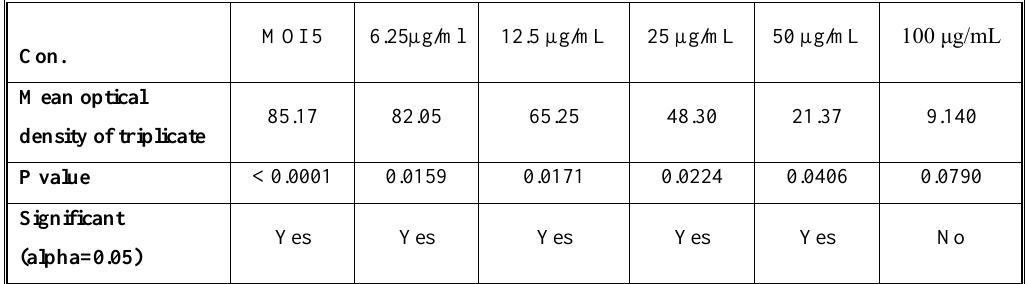
Table 3. The statistical result of the tested sample (aqueous layer) against the cytotoxicity of measles virus using MOI of 5.